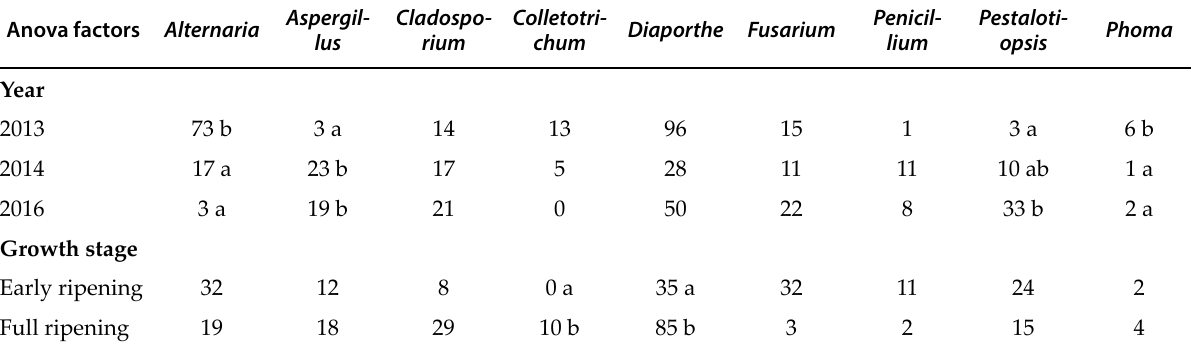
Different letters indicated significant differences ( P ≤0.05), based on the Tukey’s test.